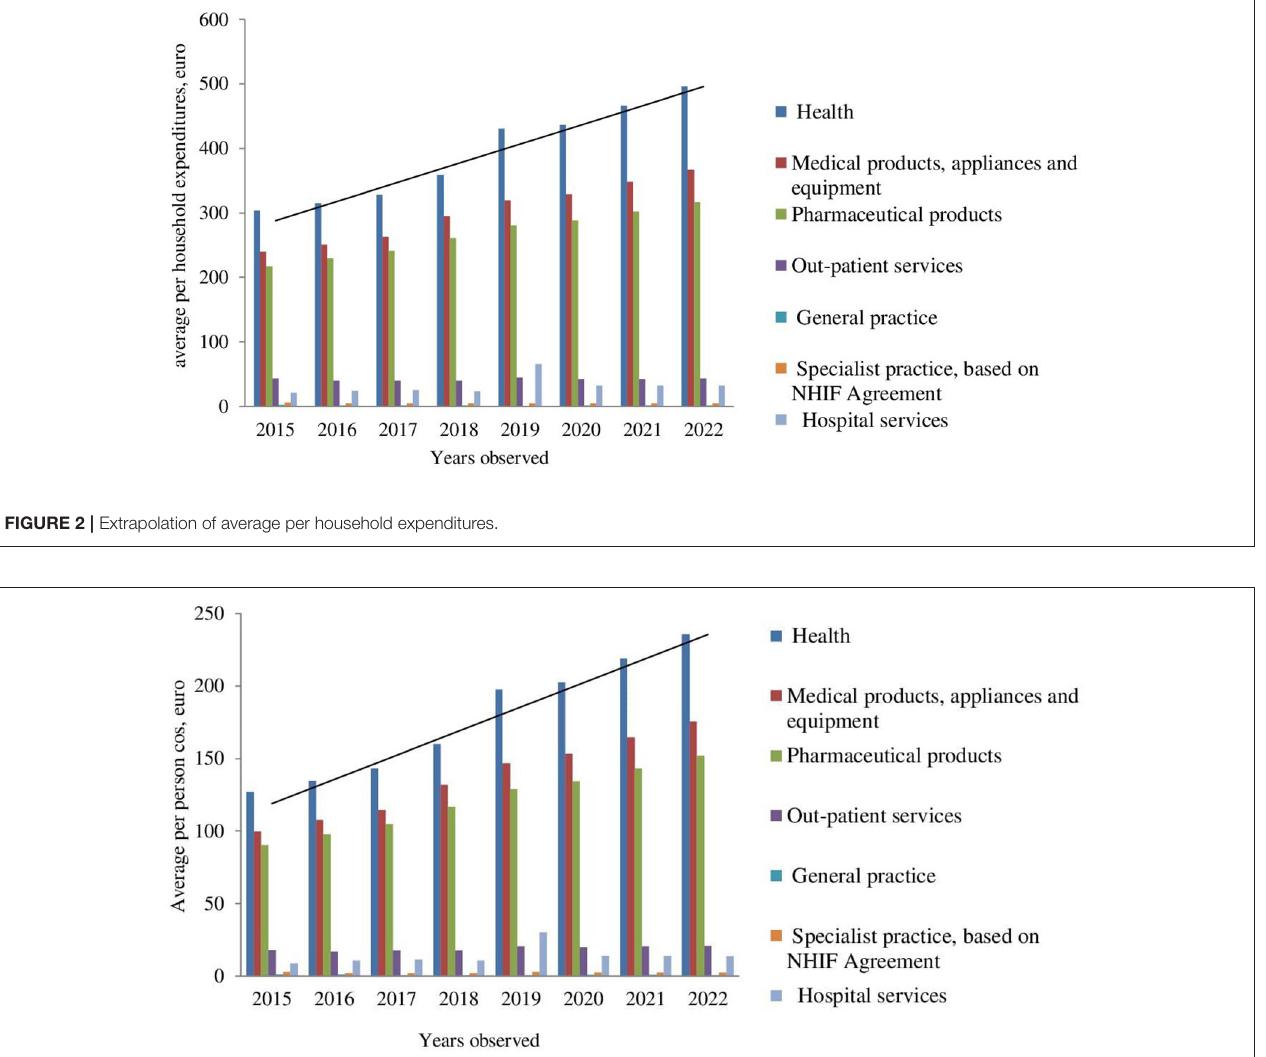
FIGURE 3 | Extrapolation of average per person